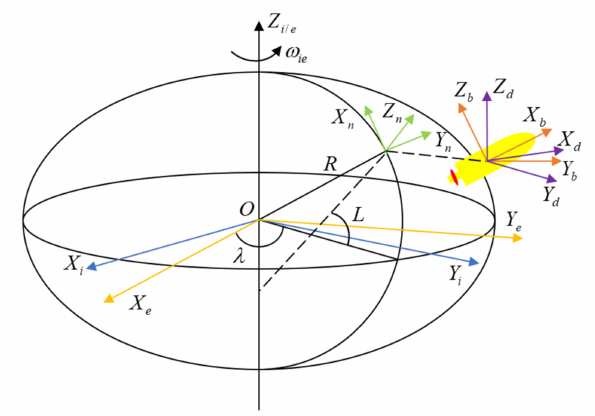
Figure 1. Schematic diagrams of various commonly used reference